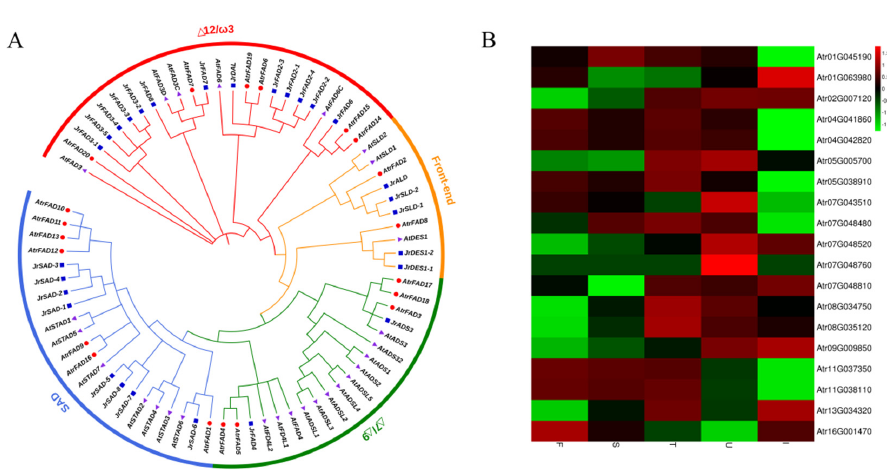
Figure 4. Putative fatty acid desaturase (FAD) unigenes identified in A. trifoliata . ( A ) Phylogenetic analysis of JrFADs ( Juglans regia L.), AtFADs ( Arabidopsis thaliana ), and AtrFADs ( A. trifoliata ) using nucleotide sequences. ( B ) Heat map of AtrFADs based on FPKM.